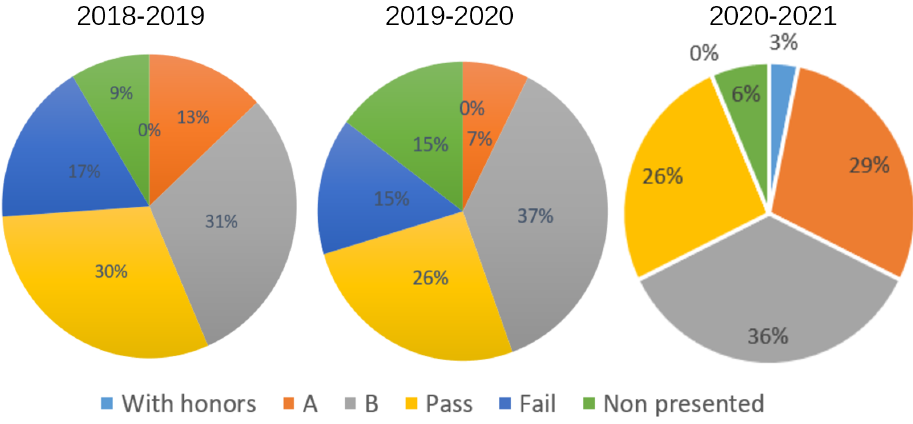
Figure 3. Distribution of